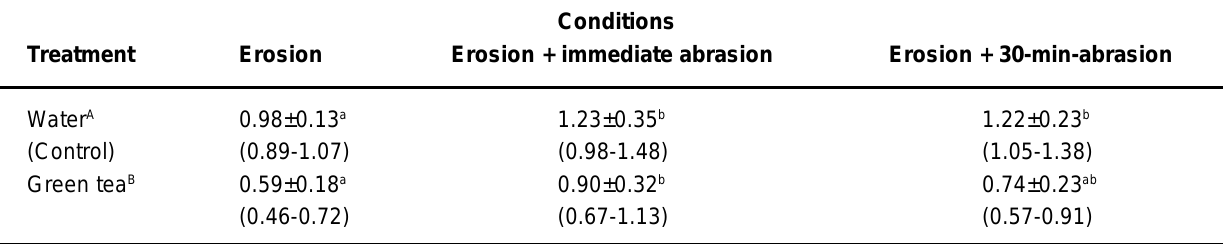
Different uppercase letters in the columns indicate statistically significant differences between the treatments. Different lowercase letters in the rows indicate statistically significant differences among the conditions (2-way repeated-measures ANOVA,